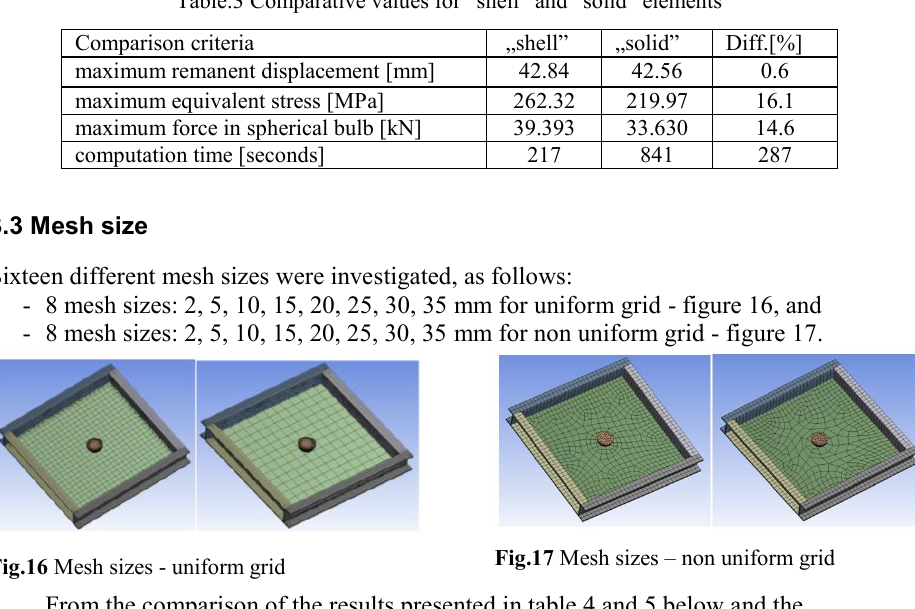
Fig.14 Model used for simulation